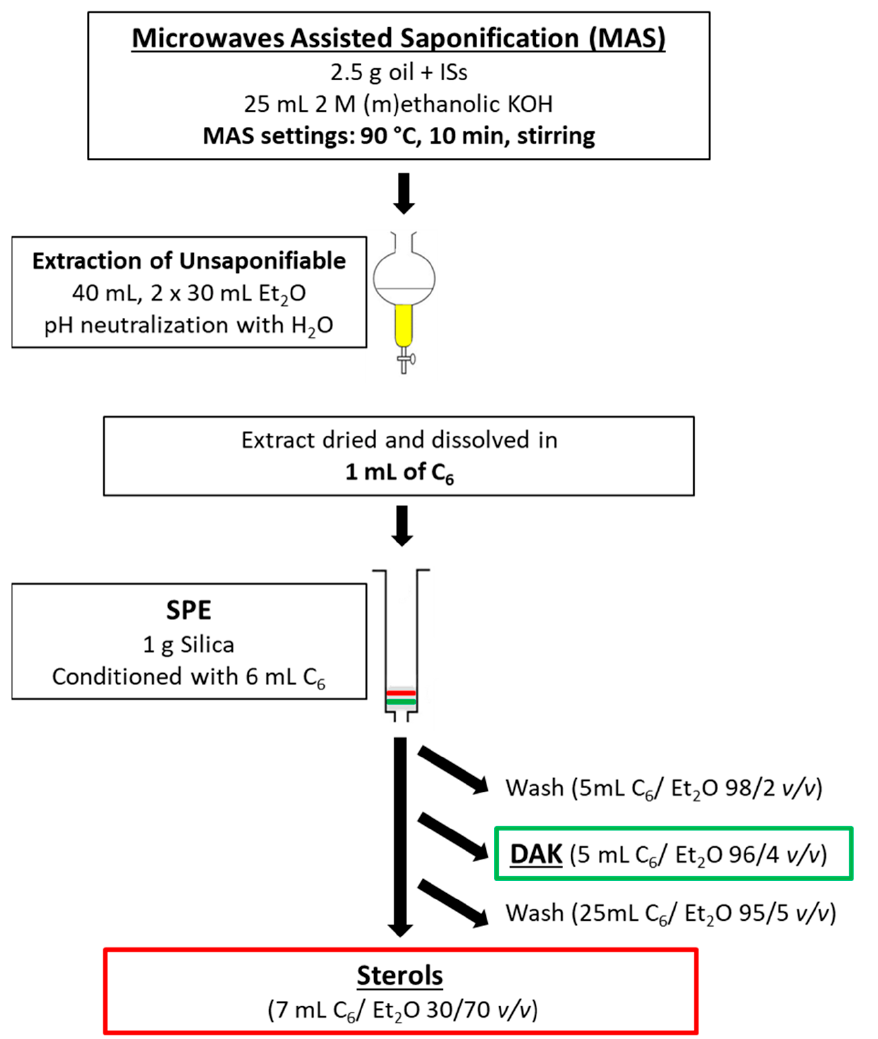
Figure 1. Scheme of the sample preparation procedure.